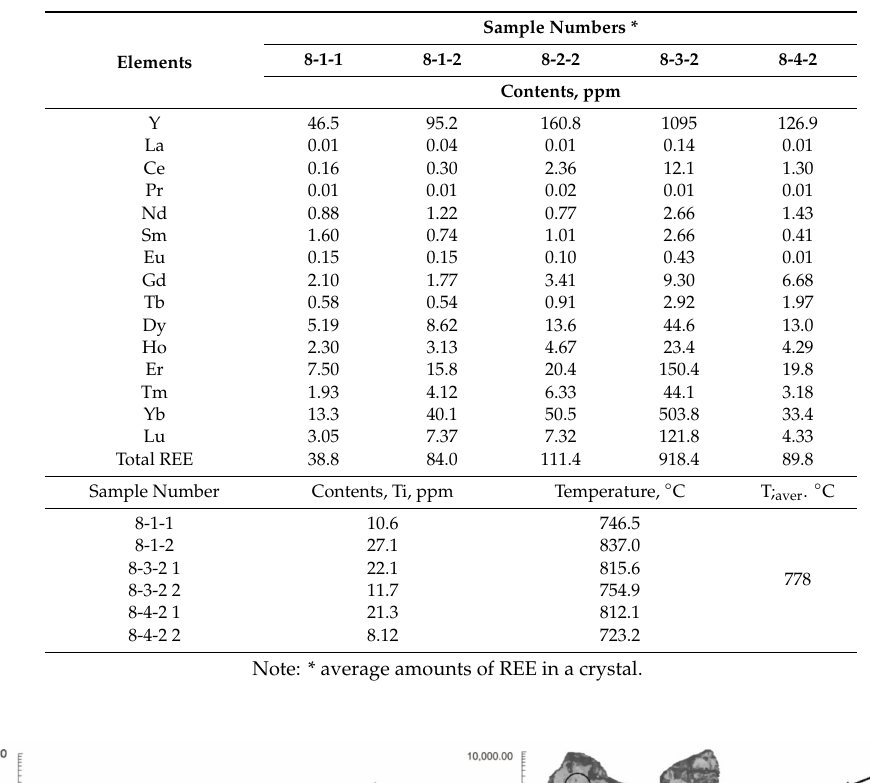
Table 1. REE, Hf, and Ti contents in zircon from metagabbro of the Kolvitsa massif.